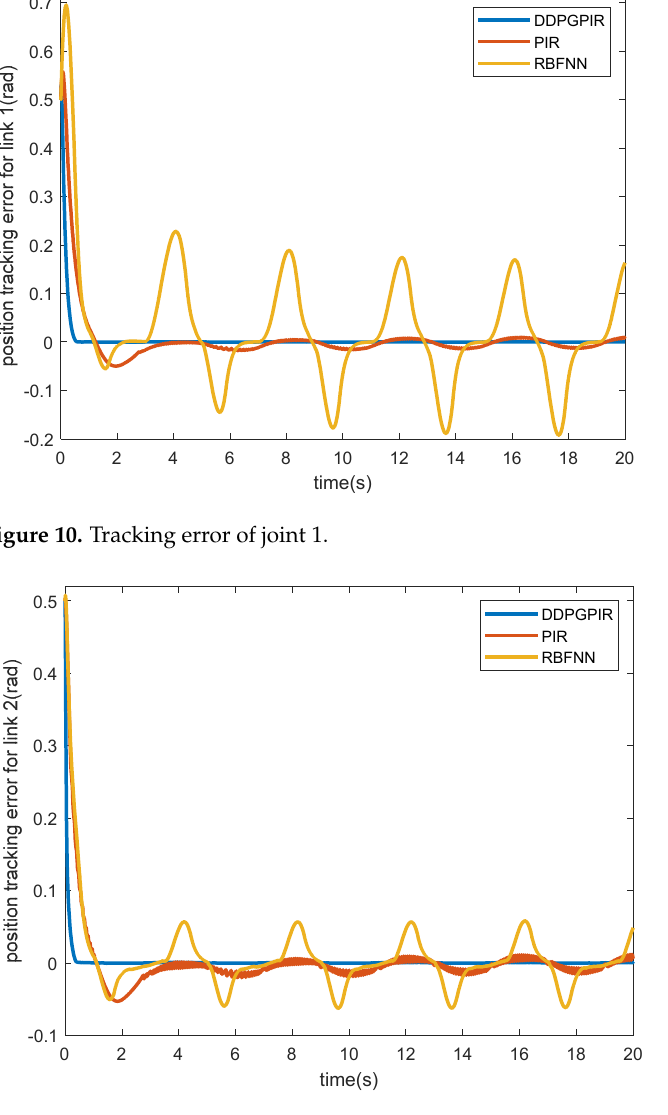
Figure 11. Tracking error of joint 2.